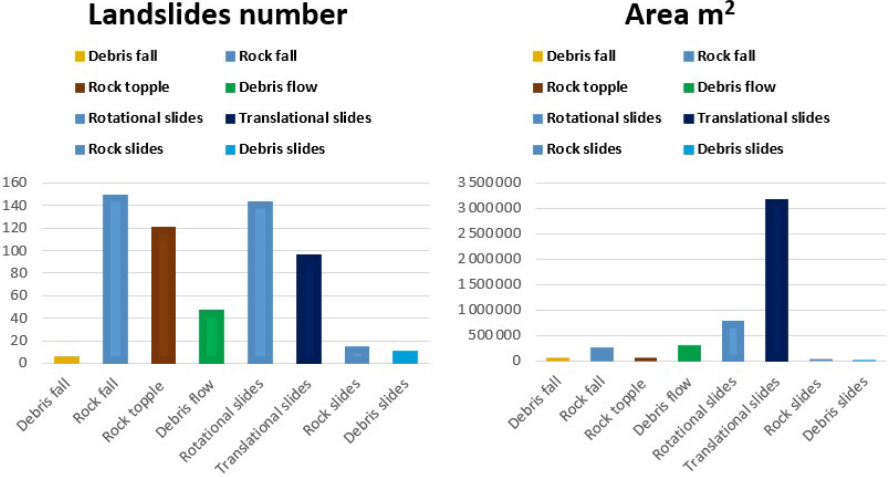
Figure 4. The relative distribution of landslides by type and area in the ETUs of the study area.